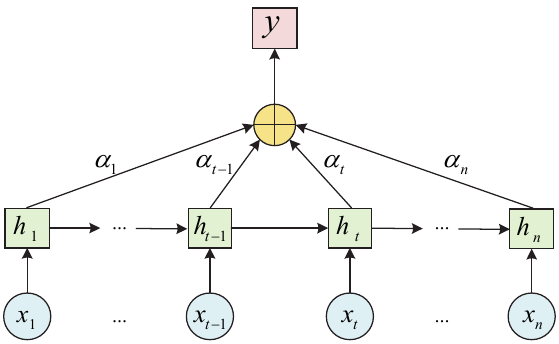
Figure 8. Structure of attention mechanism.